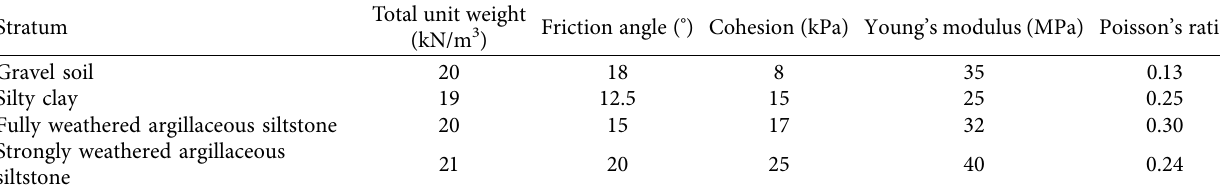
Table 1: Soil and rock